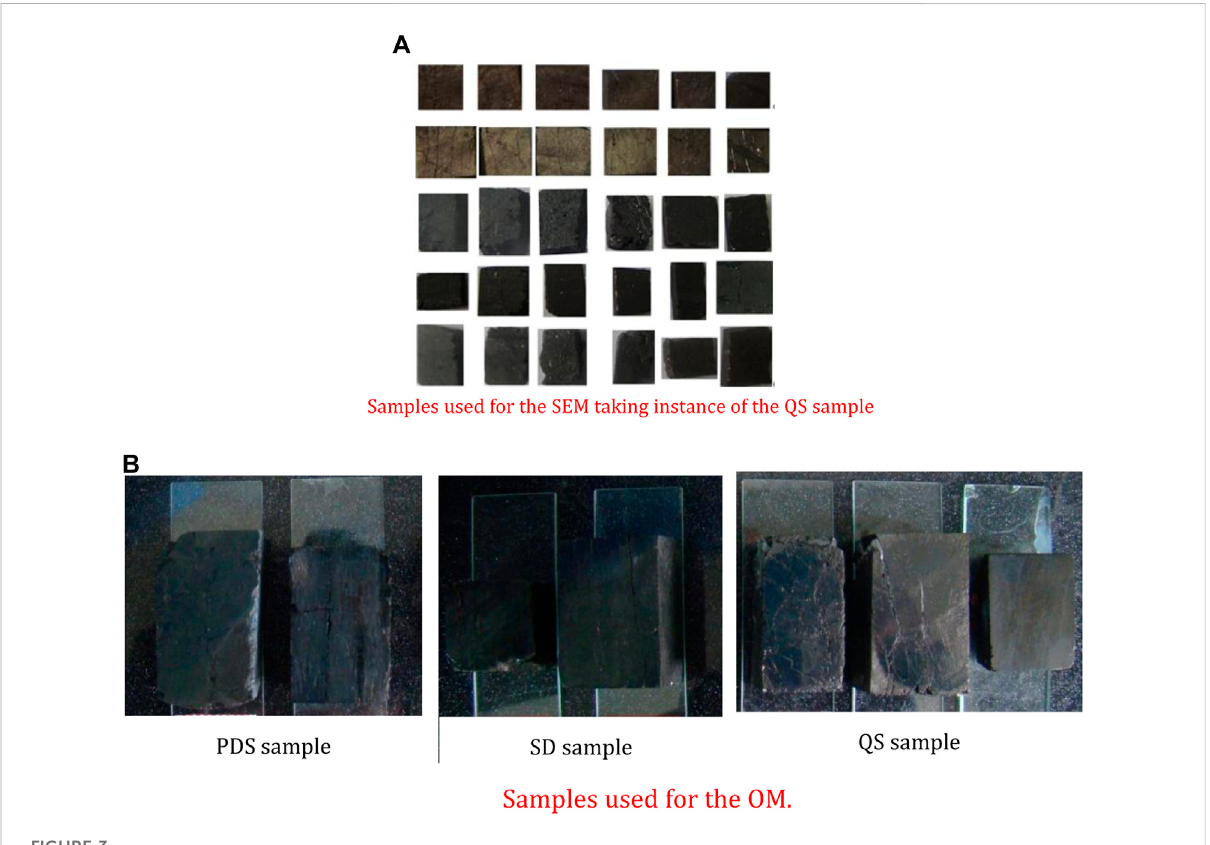
FIGURE 3 Prepared oriented coal